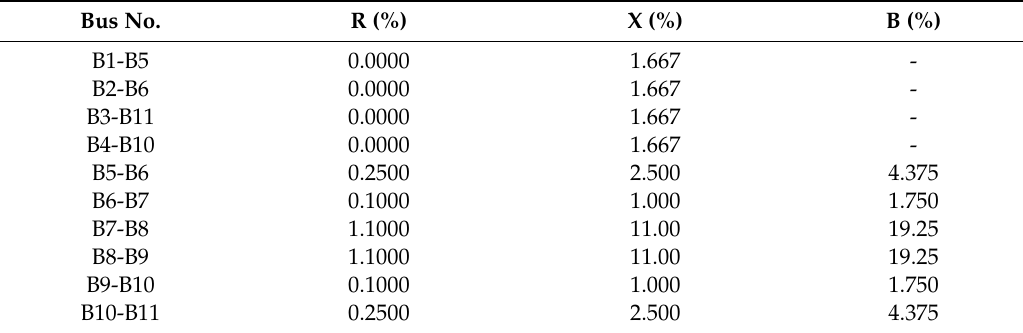
Table 2. Line parameters of Kunder’s AC network.